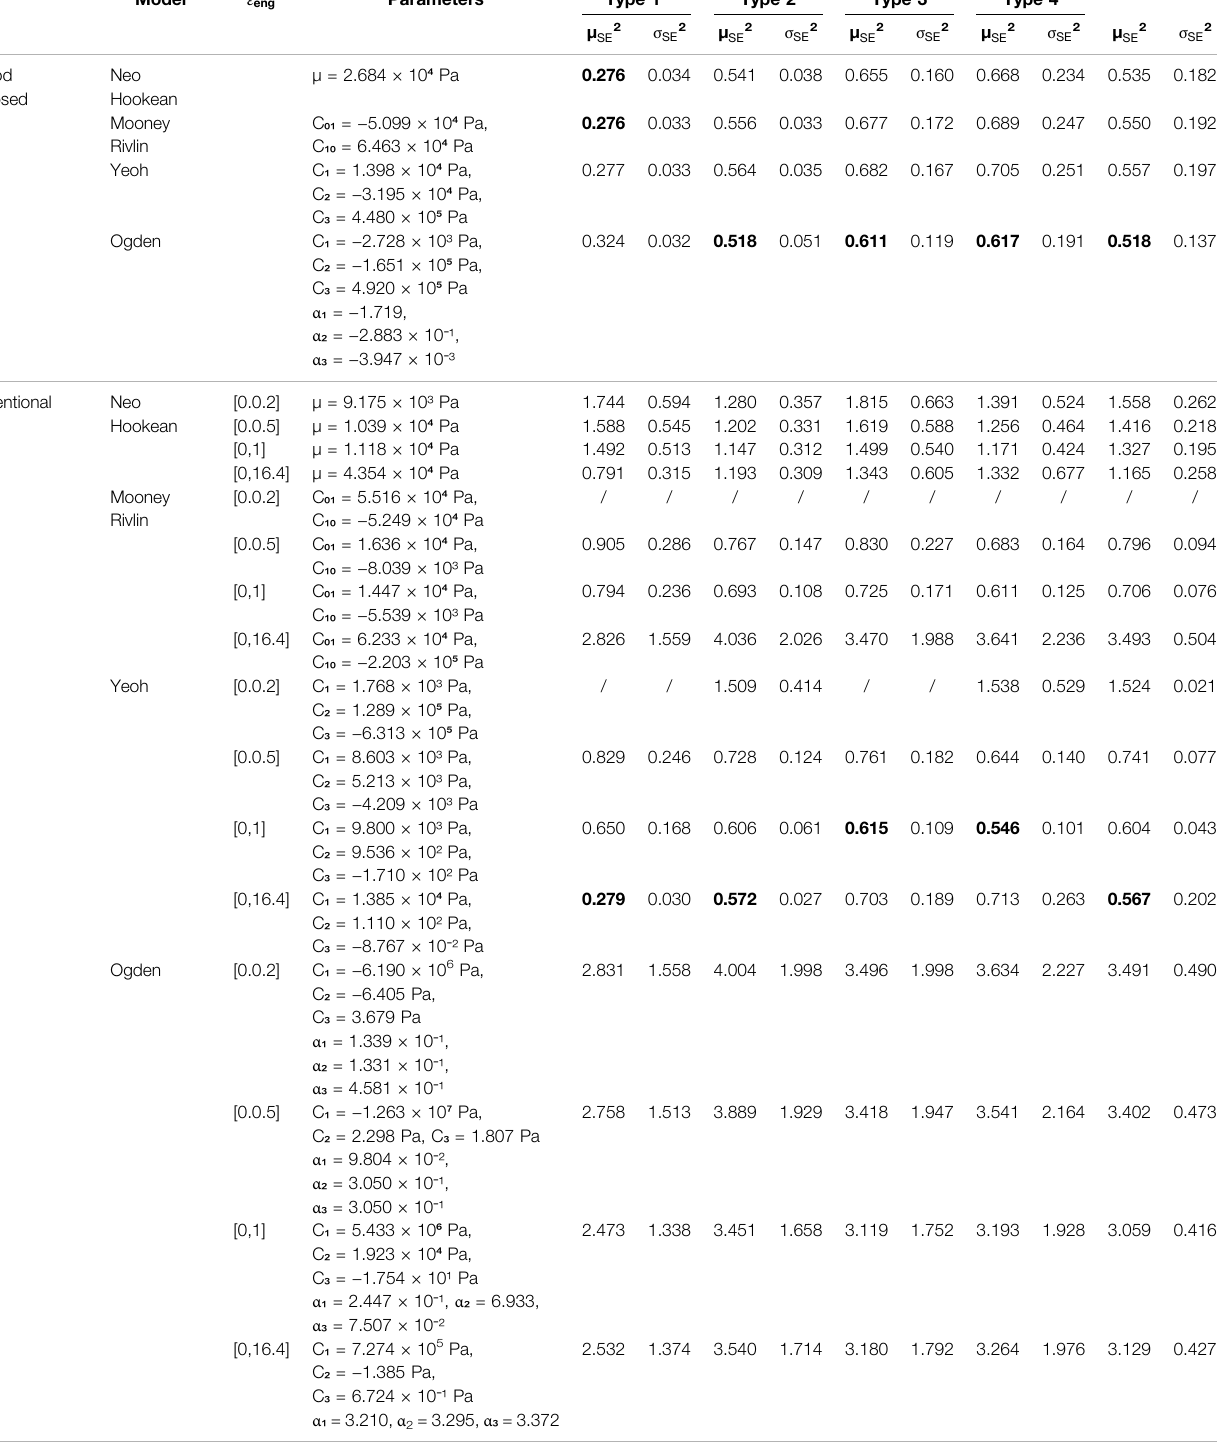
TABLE 6 | Results for Eco fl ex ™ 00-50. The best result for each methodology is shown in